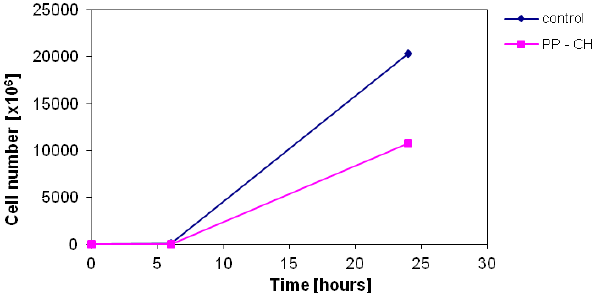
Figure 10: Time dependance of Escherichia coli cell number growing in the presence of PPNW coated with chitosan (PP-CH) in comparison with samples without PPNW (control).